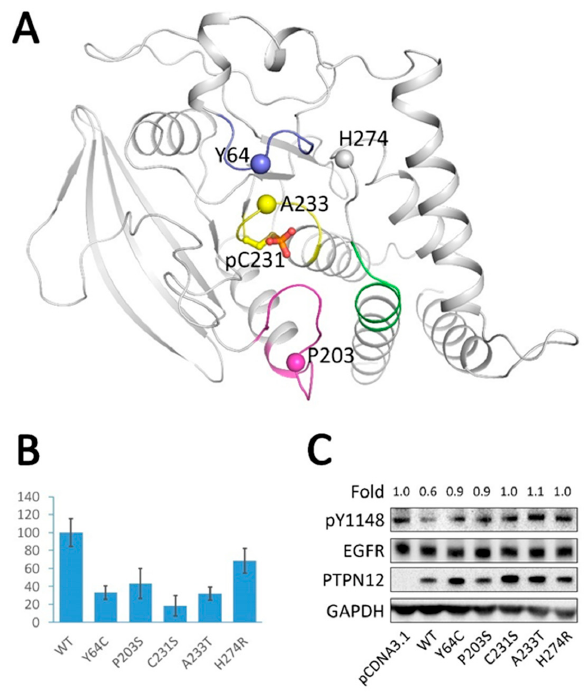
Figure 5. Analysis of tumor-derived mutations in PTPN12. ( A ) Tumor-derived mutation sites